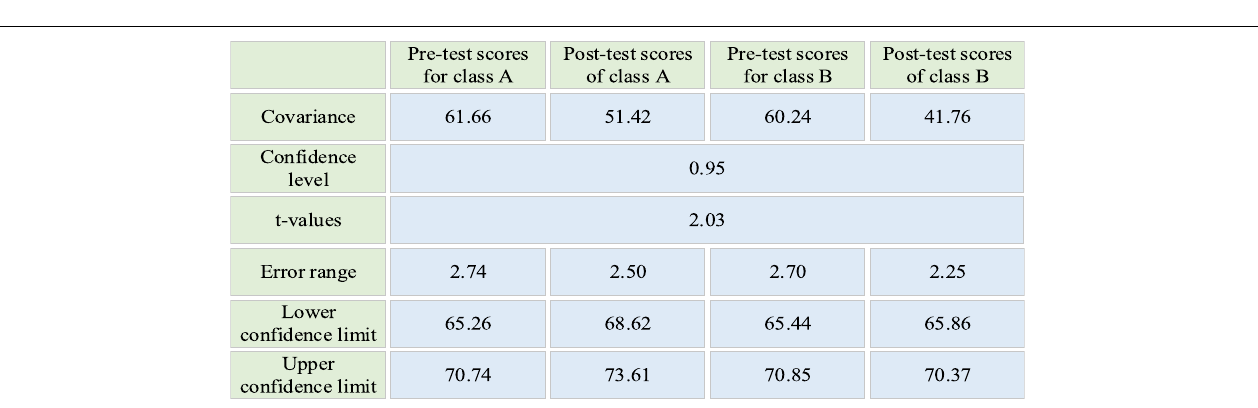
FIGURE 5 | Post-test scores of students in Classes A and B. (A) Is the post-test score of Class A, (B) is the post-test score of Class B.